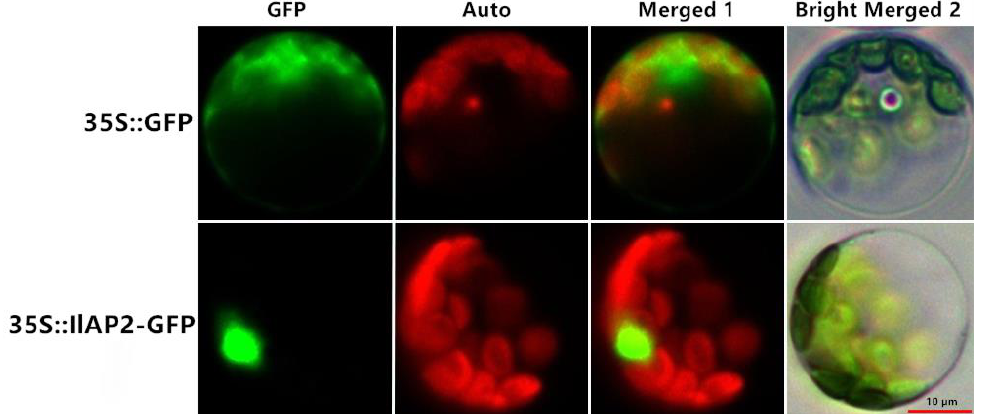
Figure 2. Subcellular localization of IlAP2 in A. thaliana leaf cells, with GFP as control. Green fluorescence protein (GFP), chlorophyll autofluorescence (Auto) and merged images (Merged 1 and Bright Merged 2) are shown. Scale bar: 10 μm.